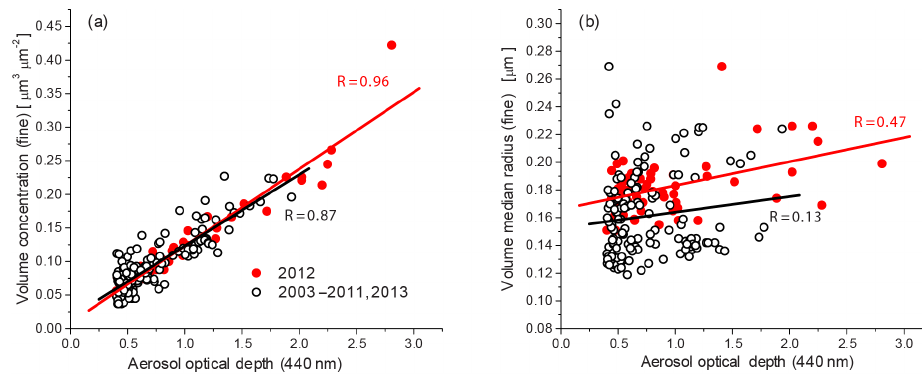
Figure 9. (a) Fine-mode volume concentration and (b) median radius vs. AOD(440nm) in Tomsk.